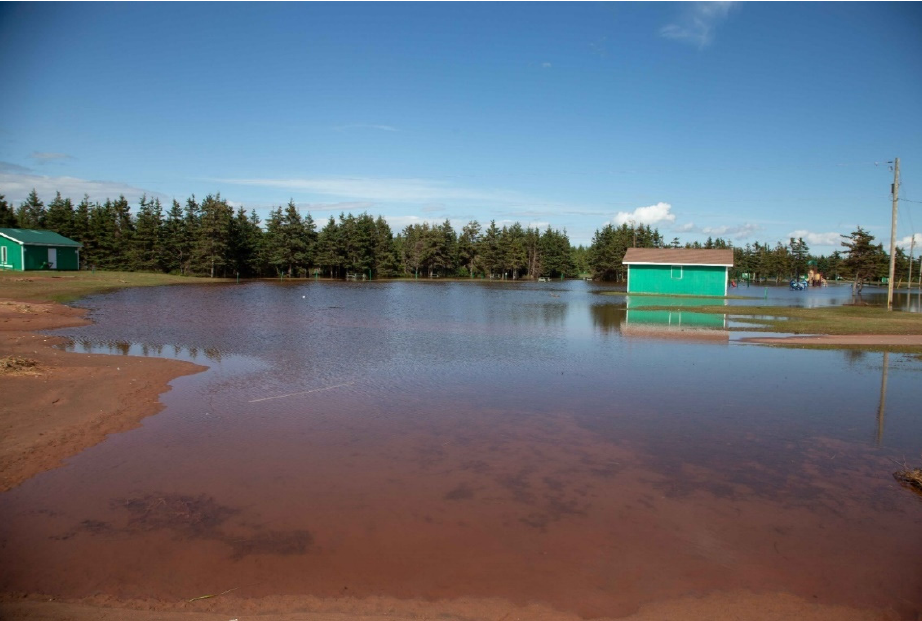
Figure 8. Storm Surge Flooding West Point, PEI.